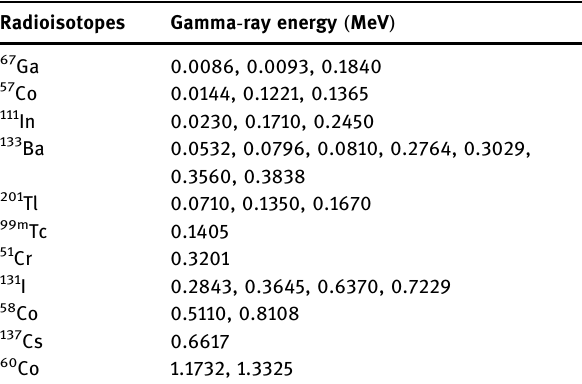
Table 2: Gamma ray energies of nuclear - type radioisotopes Radioisotopes